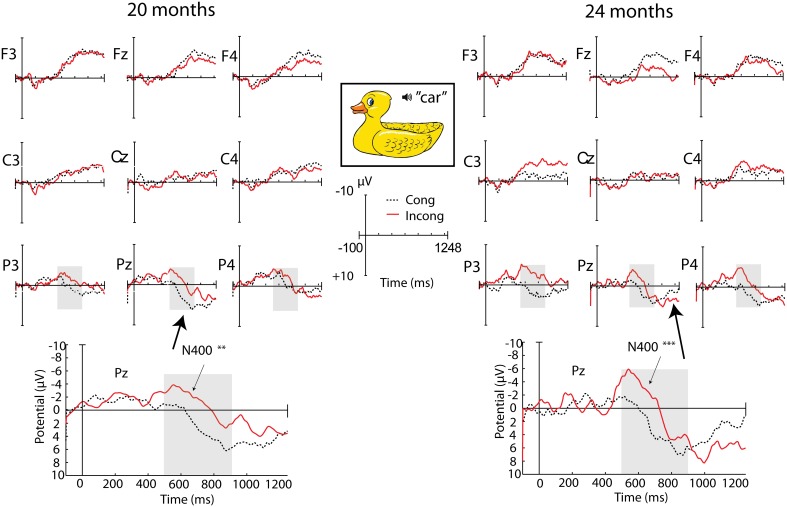
ERPs to incongruous vs. congruous words presented with regular pictures. Regions and time window with significant effect of congruity are shaded. **p < 0.03; ***p < 0.01.